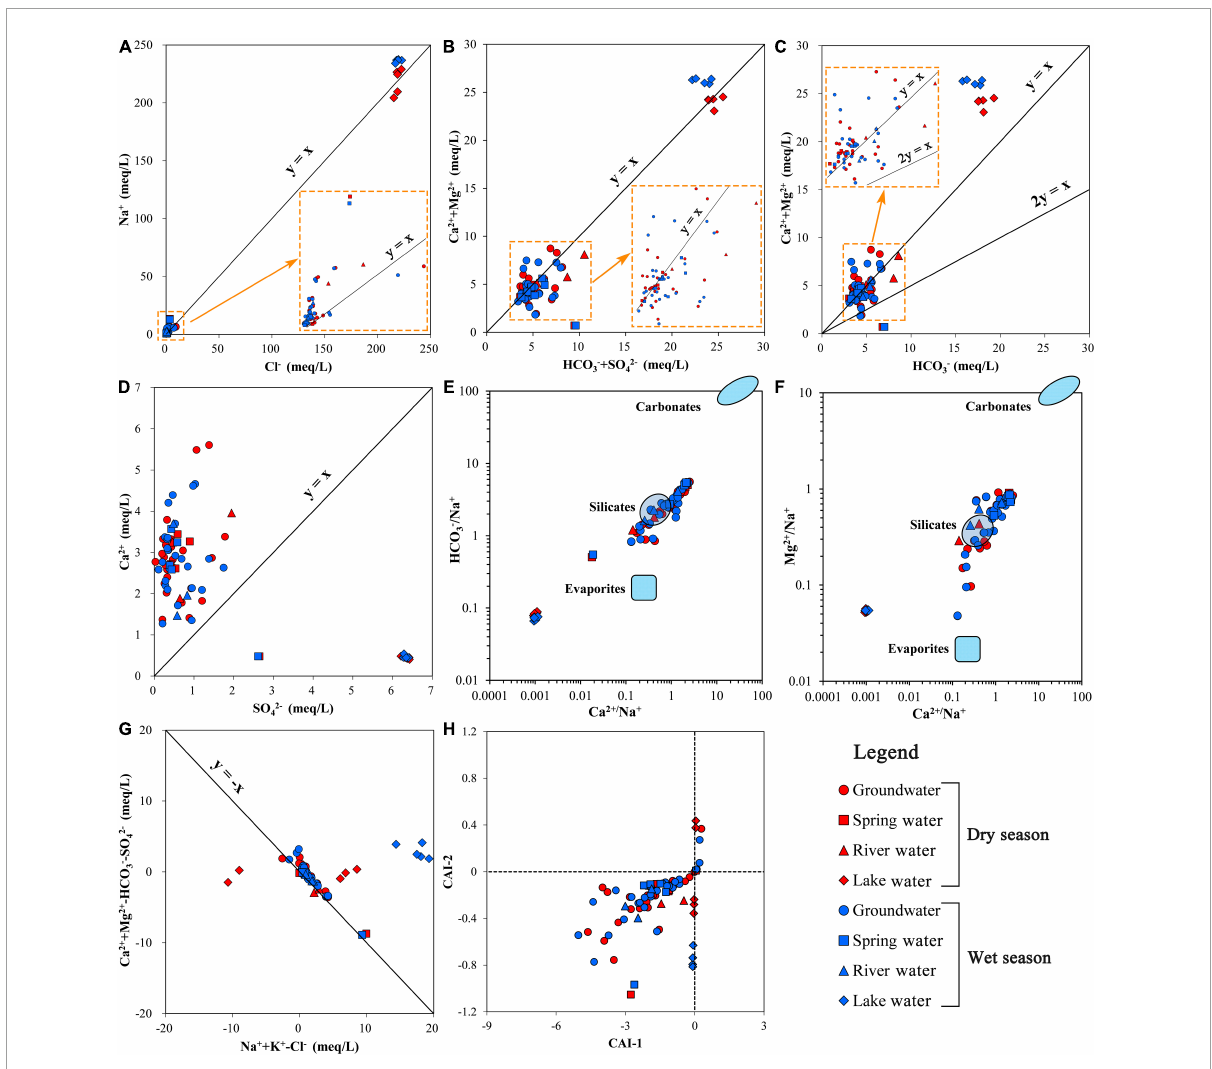
FIGURE8 Ion ratios of the water bodies in Daihai Lake Basin: (A) Cl − vs. Na + , (B) (HCO − 3 + SO 42 − ) vs. (Ca 2 + + Mg 2 + ), (C) HCO − 3 vs. (Ca 2 + + Mg 2 + ), (D) SO 42 − vs. Ca 2 + , (E) Ca 2 + /Na + vs. HCO − 3 /Na + , (F) Ca 2 + /Na + vs. Mg 2 + /Na + , (G) (Na + + K + – Cl − ) vs. (Ca 2 + + Mg 2 + – HCO − 3 – SO 42 − ), and (H) CAI-1 vs.